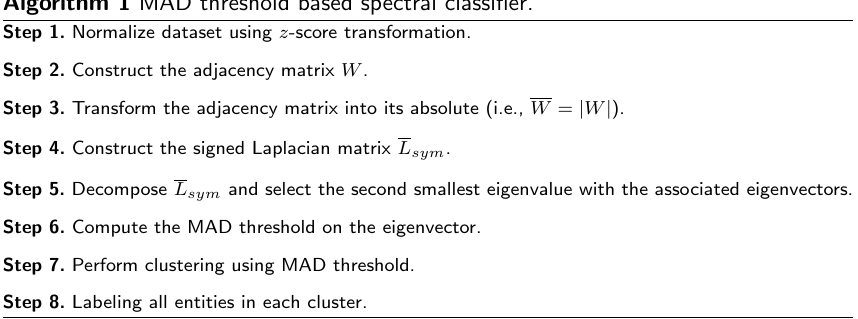
Algorithm 1 MAD threshold based spectral